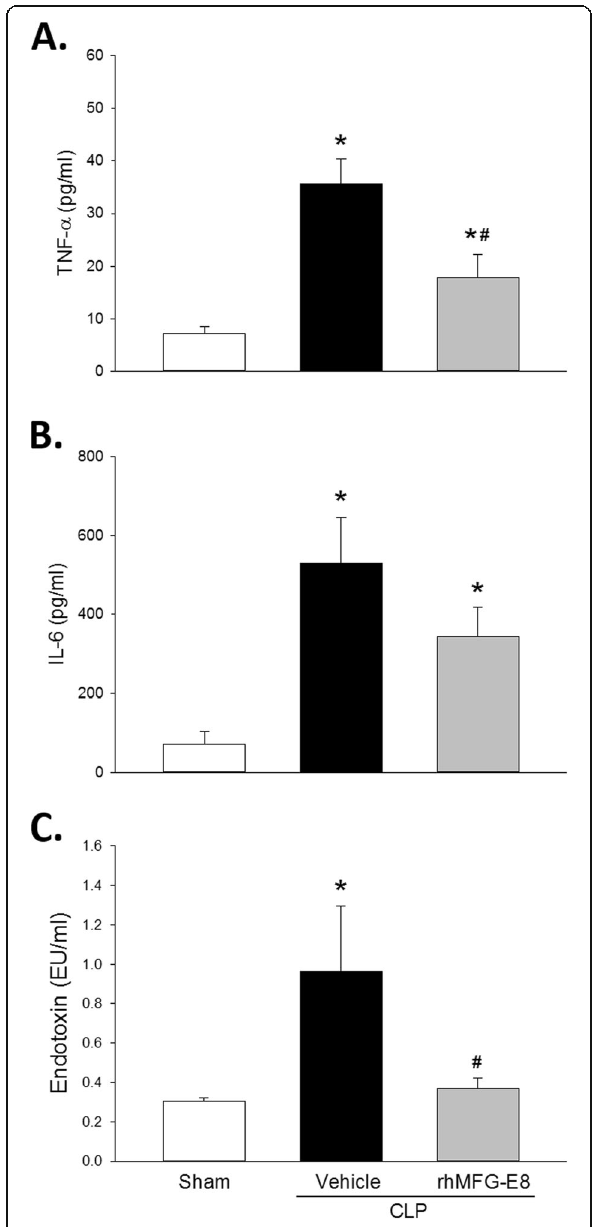
Fig. 2 rhMFG-E8 reduces systemic inflammation and bacteremia in CLP after acute alcohol exposure. Levels of ( a ) serum TNF- α , ( b ) serum IL-6, and ( c ) serum endotoxin were increased rats subjected to CLP and treated with vehicle (human albumin) compared with sham surgery, and lower in rats subjected to CLP and treated with rhMFG- E8. Prior to CLP, all rats were exposed to acute alcohol intoxication; means + SE; n = 10 – 14 for sham and n = 9 for other experimental groups; ANOVA plus Student-Newman-Keuls method, * P < 0.05 vs. Sham, # P < 0.05 vs. Vehicle treated with vehicle had alveolar septal thickening and hyaline deposits. The rats treated with rhMFG-E8, how- ever, had significantly milder changes in the lung archi- tecture and morphology compared with the vehicle